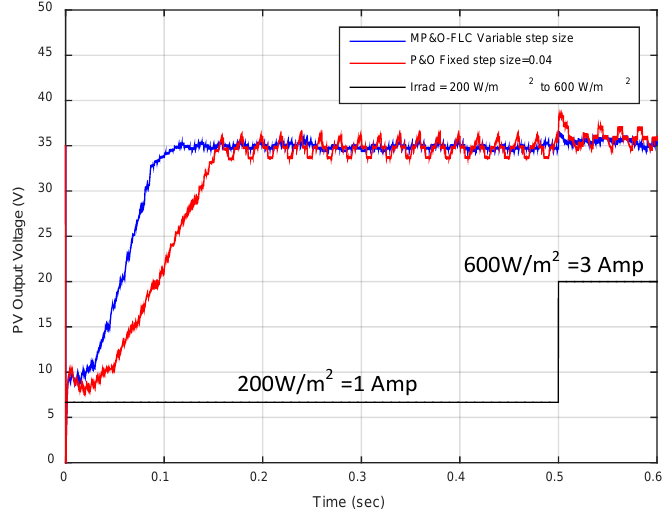
Figure 6. Comparison of conventionally fixed step size P&O MPPT and the proposed FLC-based variable step size P&O MPPT with a startup.